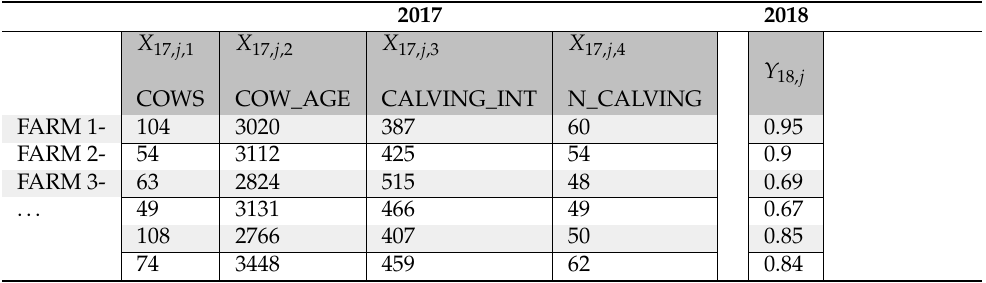
Table 3. Dataset configuration from 2017–2018. On the left side, the input scalar variables X 17,1 , X 17,2 , . . . , X 17, m . On the right side, the scalar target Y 18 .